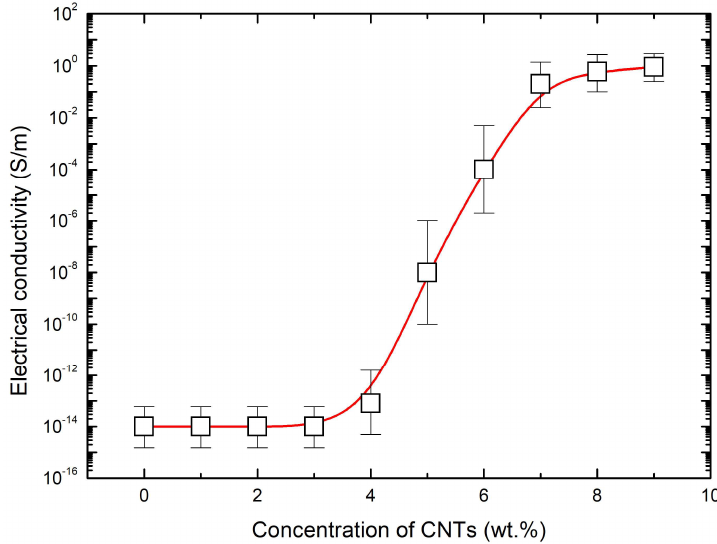
Figure 3. Electrical conductivity of CNT nanocomposites as a function of CNT concentration.